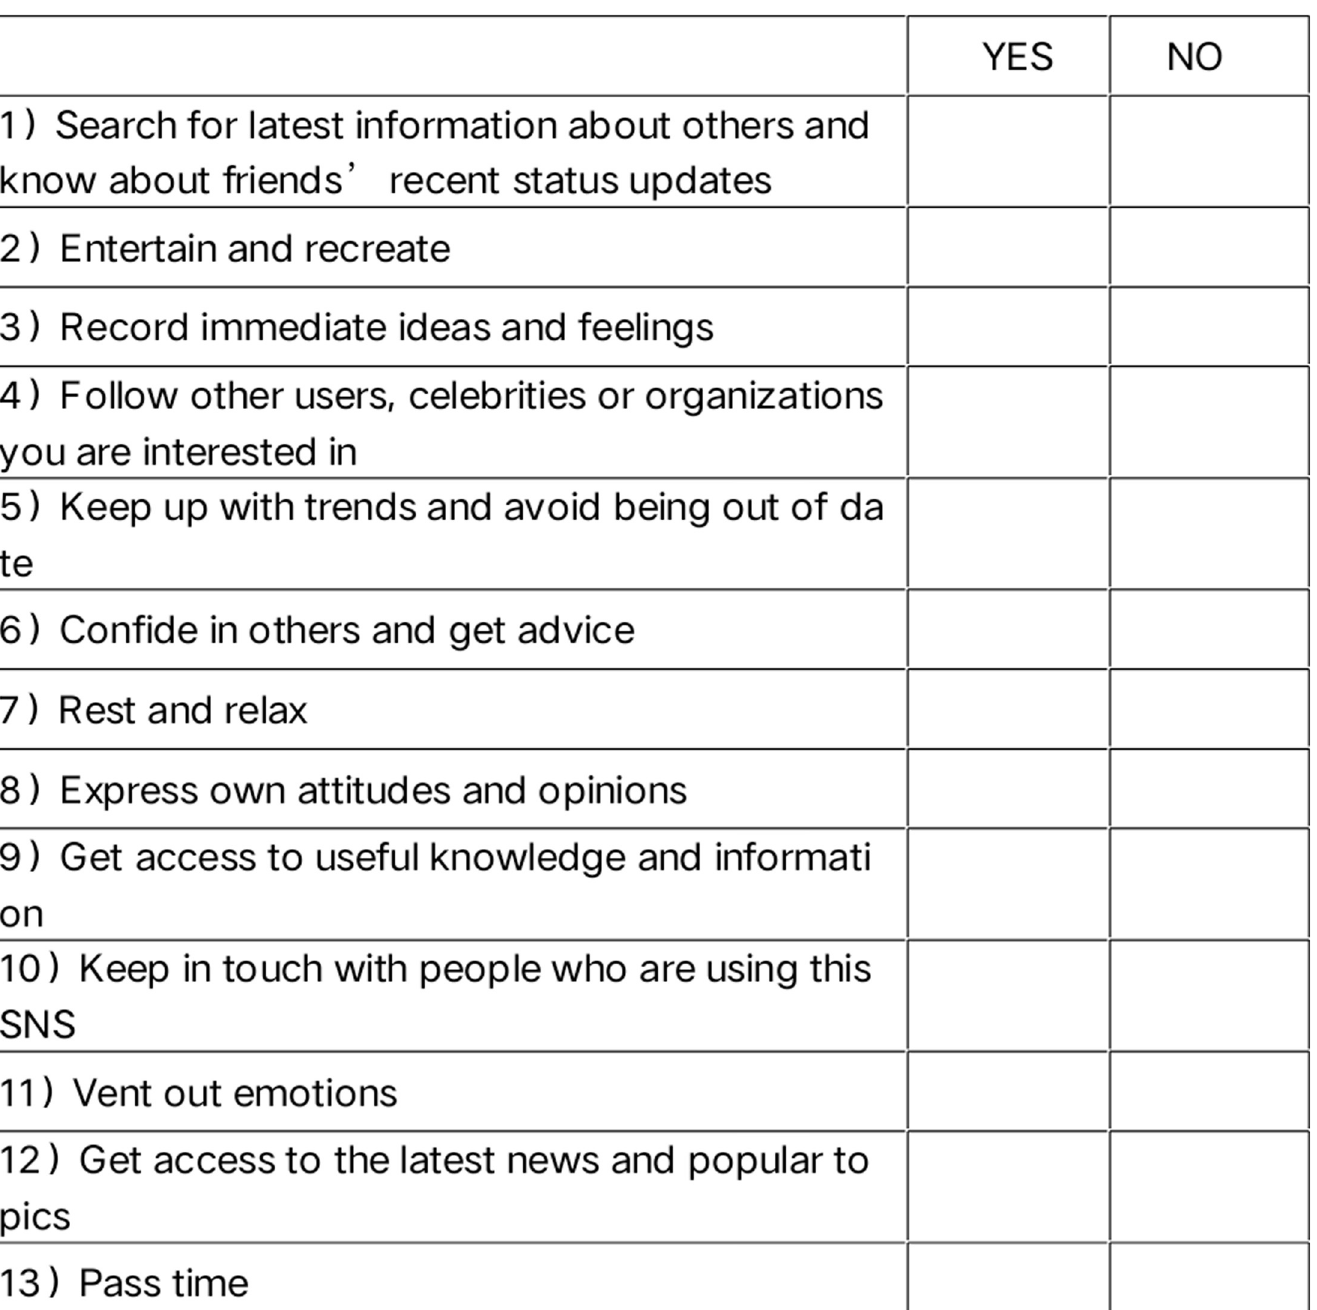
Fig 2. The SNSU-MMG sentences